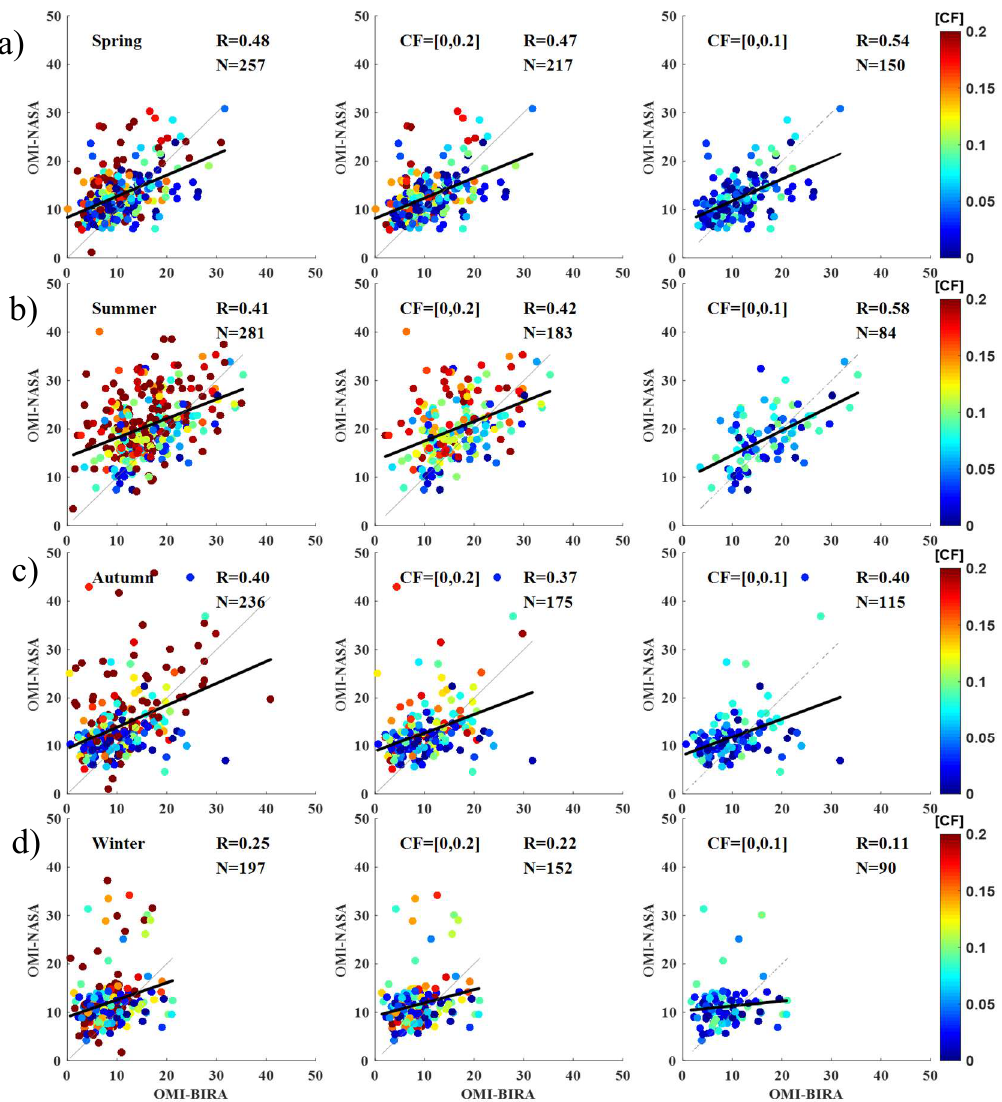
Figure A3. Daily comparisons of OMI-NASA and OMI-BIRA; left panels: 0 ≤ eCF ≤ 30%, middle panels: 0 ≤ eCF ≤ 20%, right panels: 0 ≤ eCF ≤ 10%. ( a ) Spring (MAM), ( b ) Summer (JJA), ( c ) Autumn (SON), ( d ) Winter (DJF).